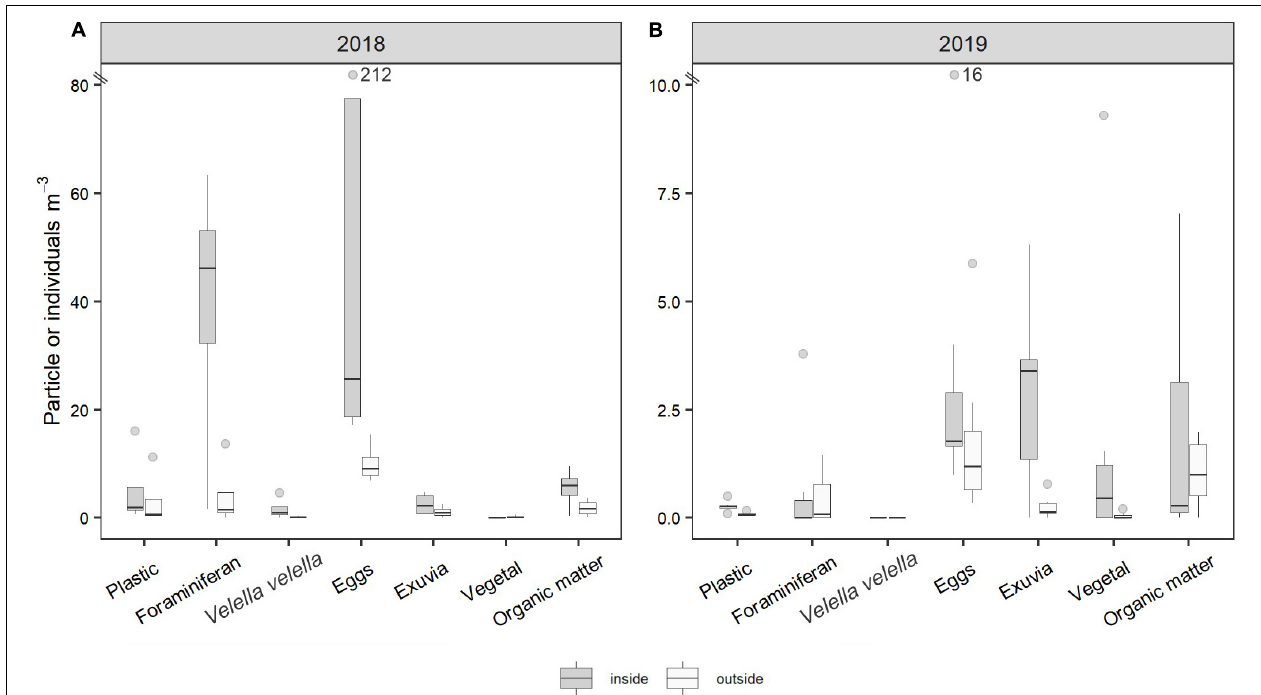
FIGURE 5 | Main passive particles and organisms. Density of organisms and particles per m 3 . Note that the scale is different between (A) and (B) . Plastic abundance are shown for reference